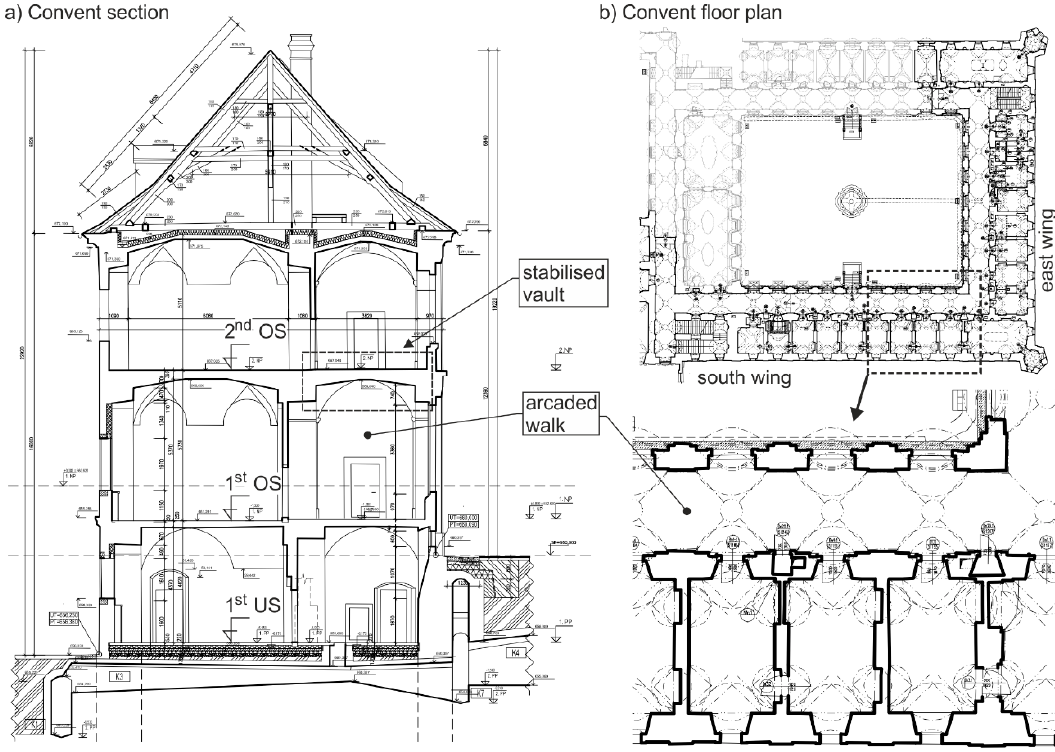
Figure 1. ( a ) Schematic section of the convent and ( b ) schematic layout plan of 1st aboveground story (OS) of the convent and detail of the floor plan.